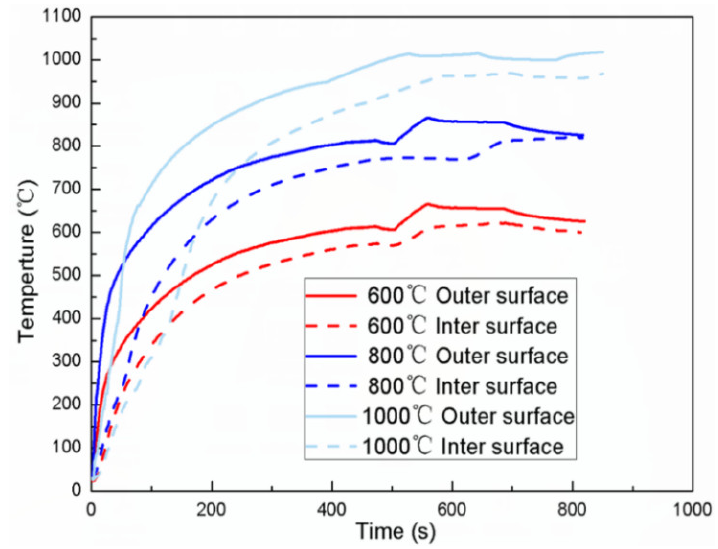
Figure 3. Temperature change of inner and outer walls of the specimen during heating.